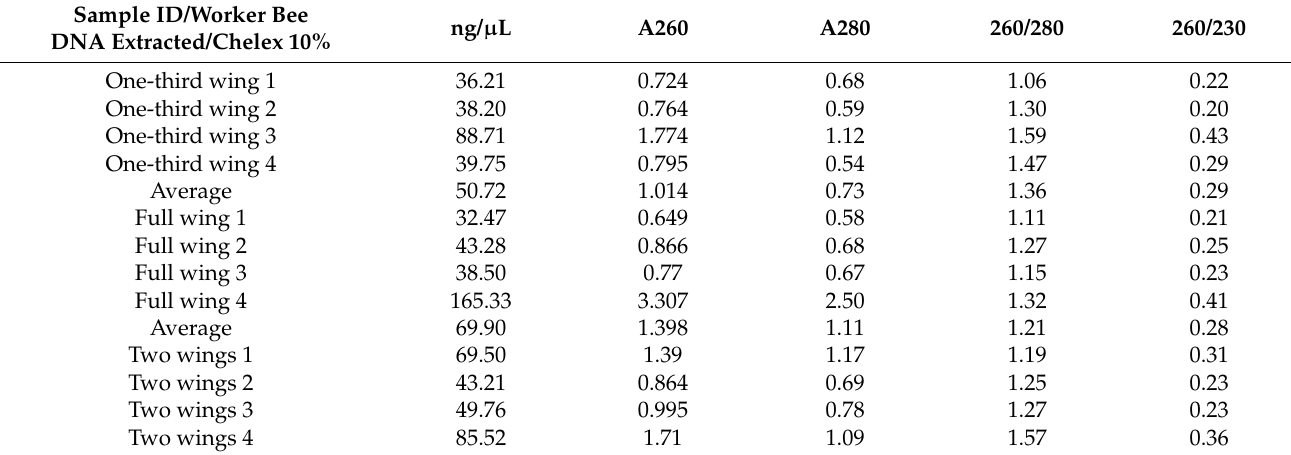
Table 1. Quantity and quality of the DNA extracted by the Chelex 10% method on honey bee worker wings and legs. Extractions were conducted on four biological replicates using a third of a wing, one full wing, two wings and a leg. UV Absorbance at 260 and 280 nm are presented as well as contamination ratios. DNA extracted from the wing, head and thorax using an extraction kit (GE Healthcare IllustraTM Triple Prep, Little Chalfont, UK) is provided for